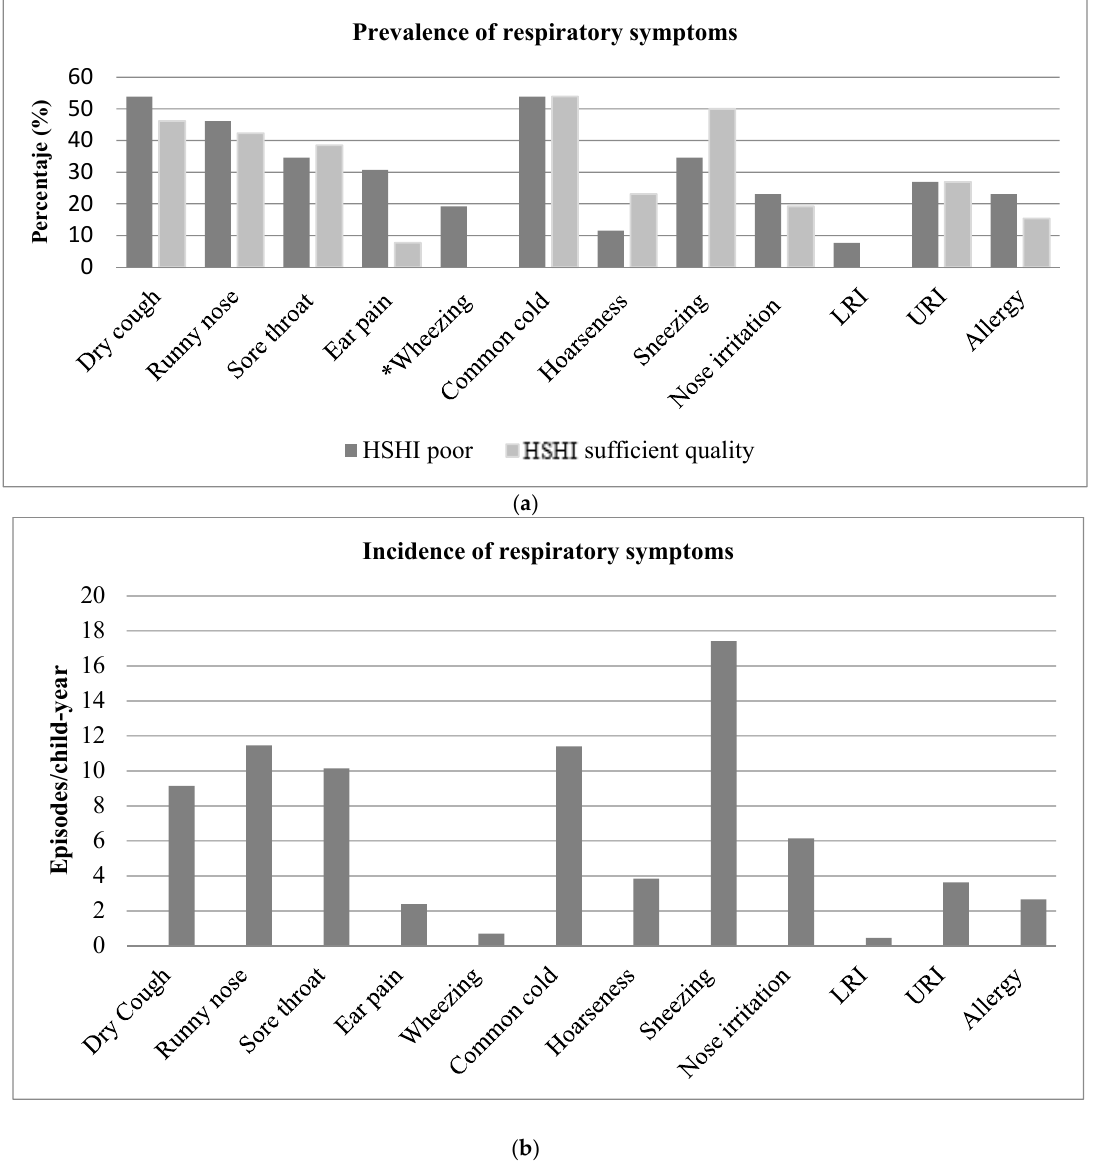
Figure 2. Frequency of respiratory symptoms for children during the follow-up period in Alpuyeca Morelos. November 2014–February 2015. N = 55. ( a ) Incidence (episodes/child-year); ( b ) Prevalence regarding HSHI. * Difference of proportions between the HSHI categories statistically significant ( p < 0.05). Schoolchildren showed some symptom at least once during the month follow-up period.